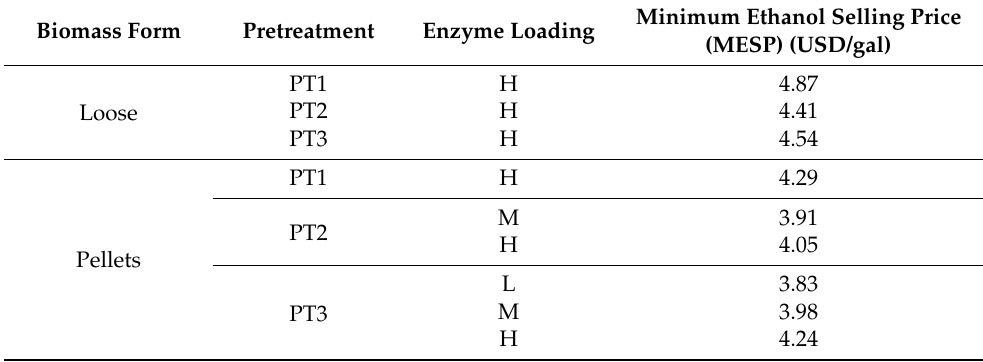
Table 6. Minimum ethanol selling price (MESP) for loose and pelleted biomass under different pre- treatment conditions and enzyme loadings (PT1, PT2, PT3, and low, medium, high enzyme loadings). Biomass Form